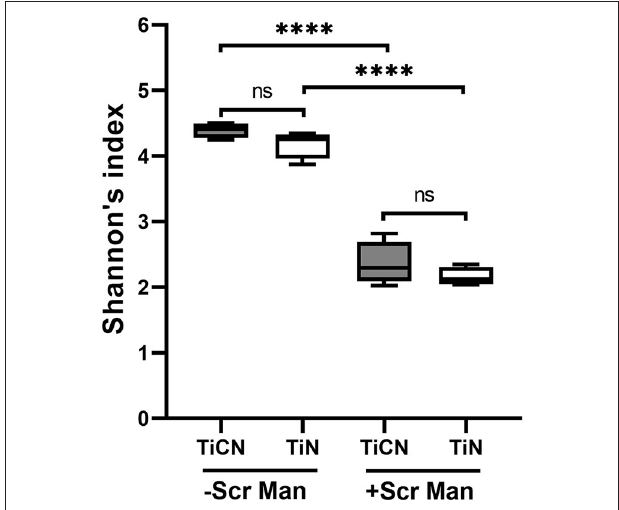
FIGURE 7 | Alpha diversity analysis of TiCN and TiN surface coatings associated oral microbial biofilm communities. Box plots representing the alpha diversity of oral biofilms formed on TiCN (gray box plot) and TiN (yellow box plot) in the absence and presence of Scr and Man are shown. The whiskers represent minimum to maximum value and a line in the box represent the median. Alpha diversity is measured by Shannon’s index representing mean species richness. ****indicates significant differences of p < 0.0001.